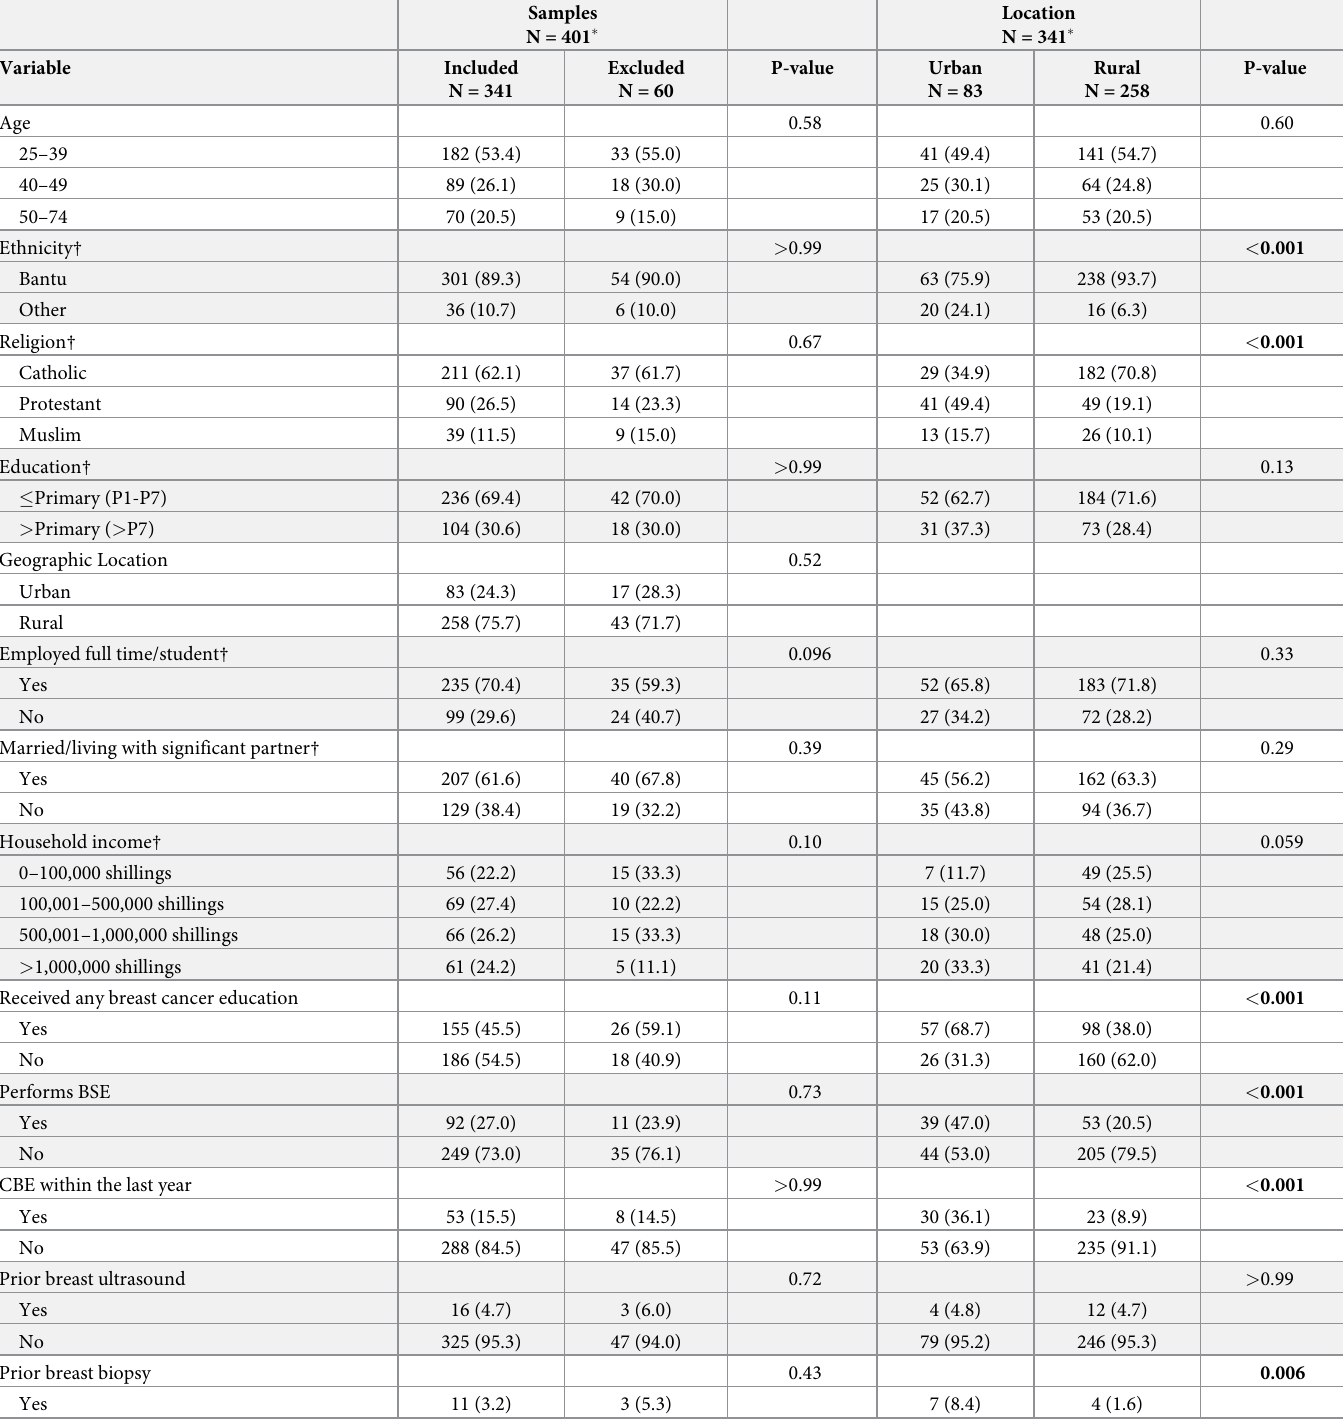
Table 1. Population characteristics and experiences with breast cancer detection